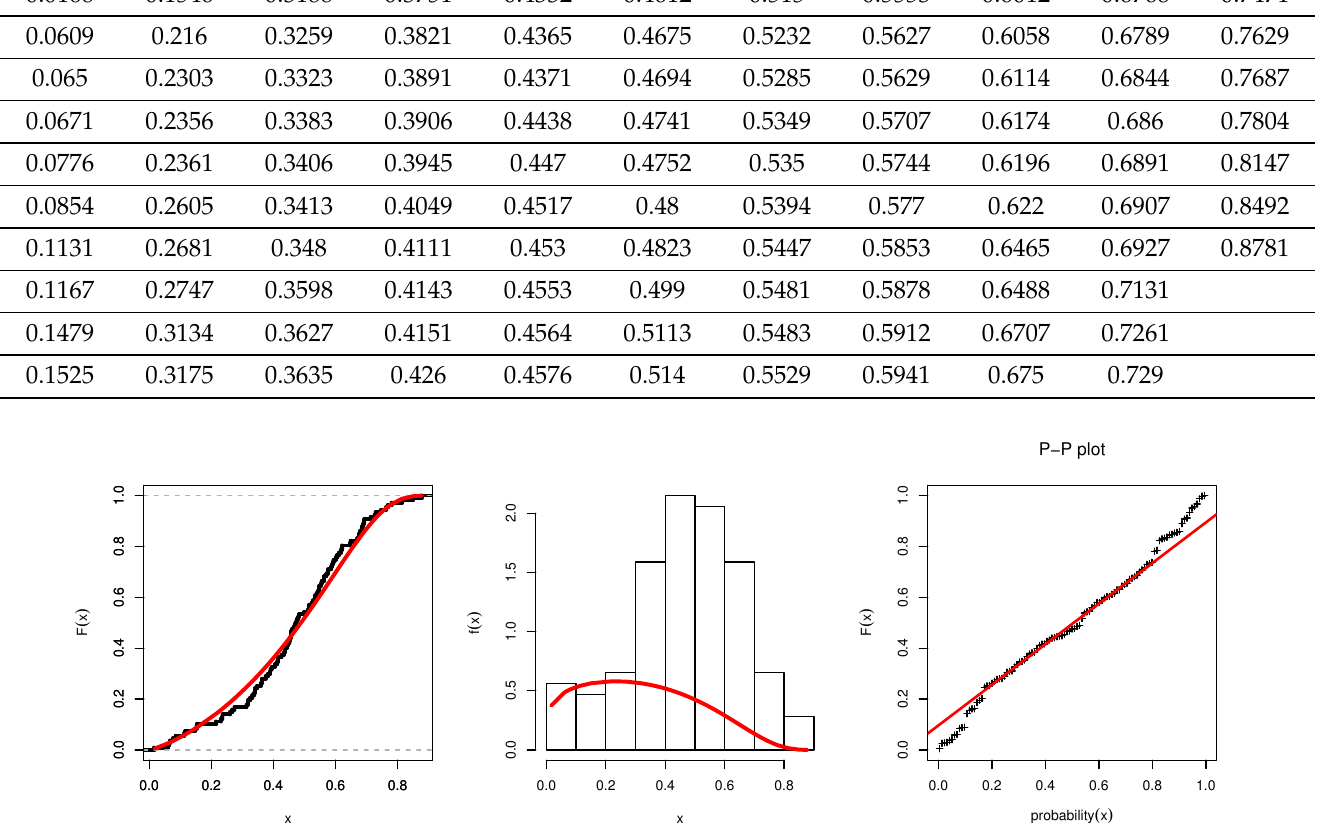
Figure 8. Estimated pdf, CDF, and P-P plots of UEPD for milk production